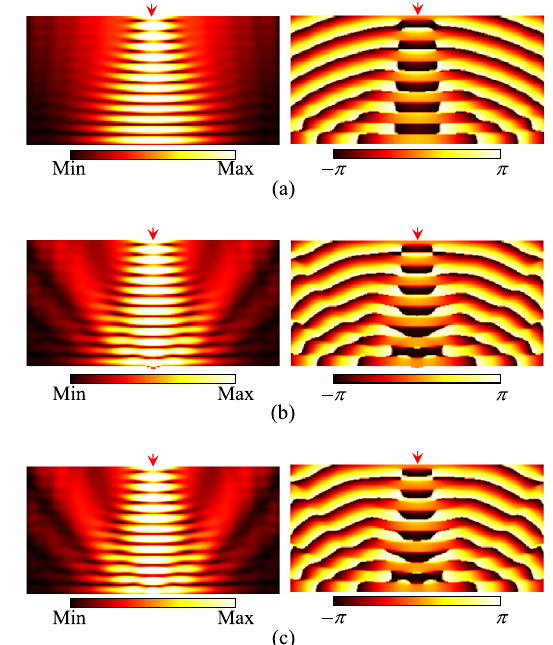
Fig. 11. Calculated complex voltage distributions for the case with the normal incident wave at the wavelength l g = 24 D d . Left: Amplitude. Right: Phase. (a) Flat surface. (b) With the original groove. (c) With the groove illusion